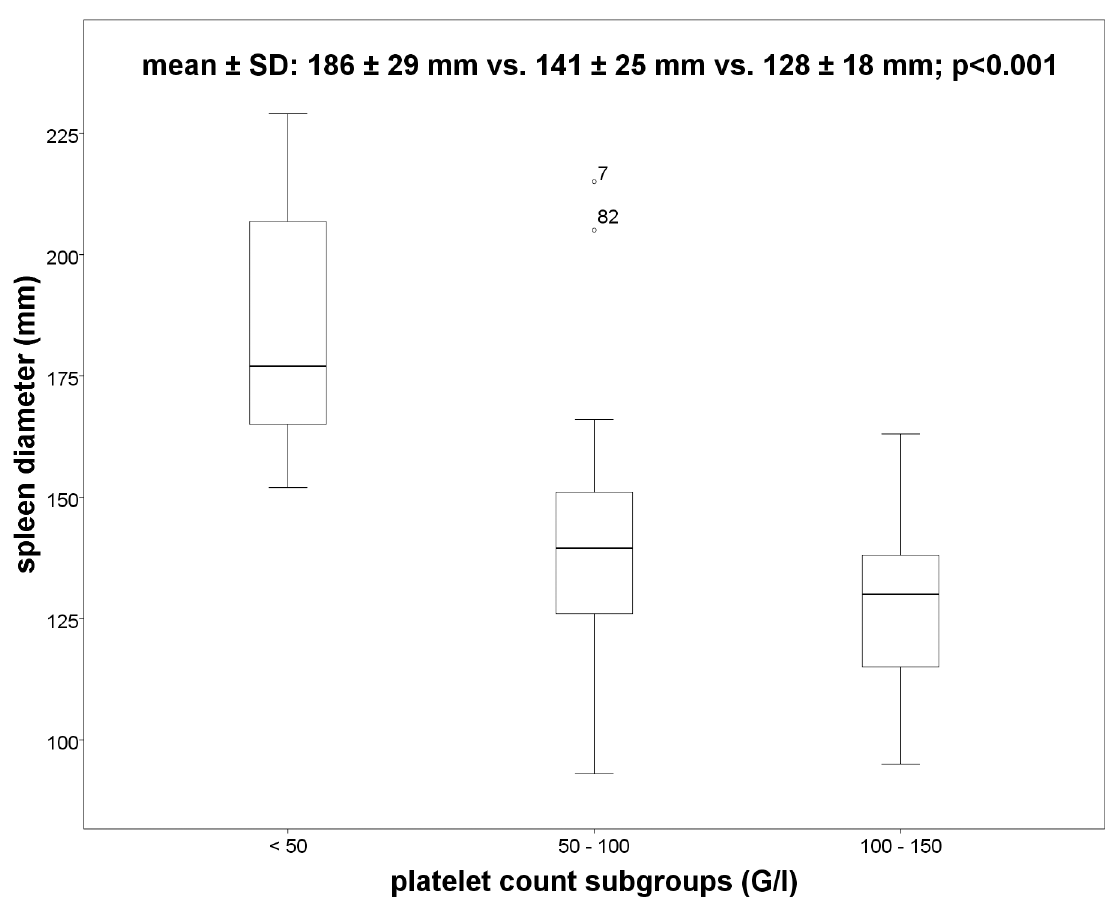
Fig 3. Boxplot: Spleen diameter and platelet count